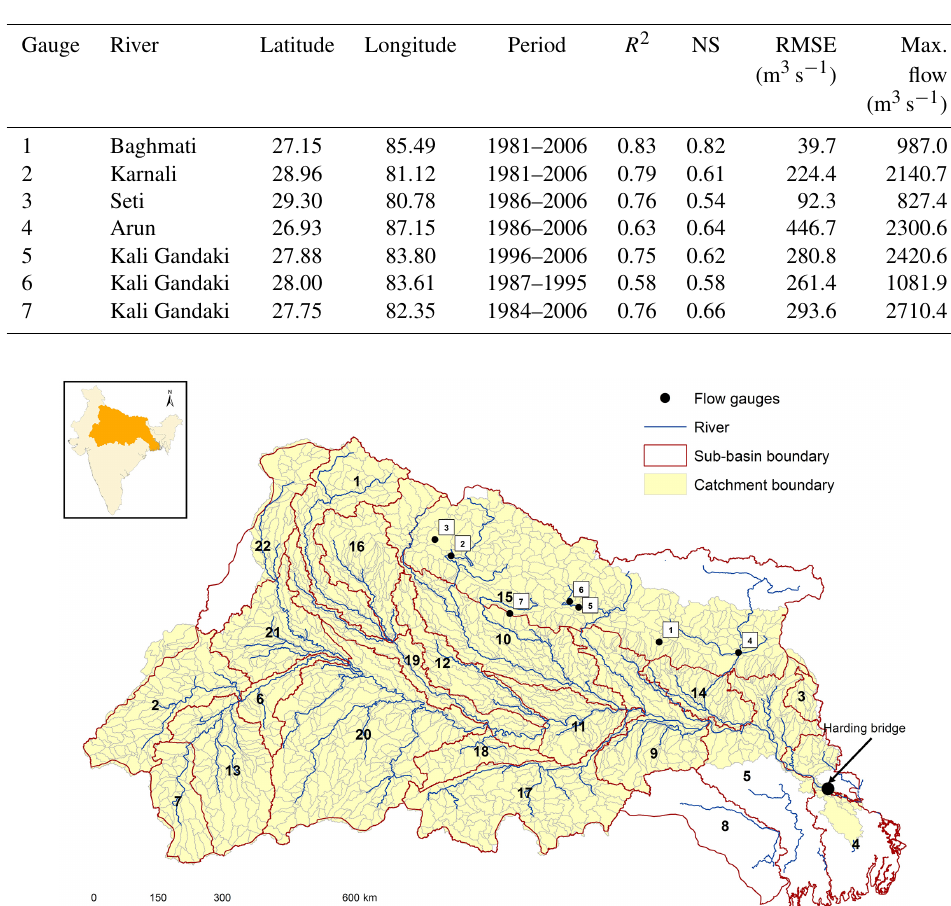
SWAT model developed for the Ganges does not entirely cover the areas that belong to West Bengal and